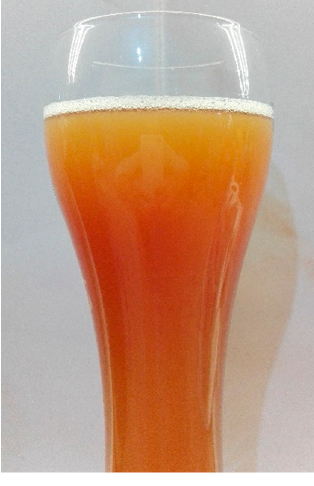
Figure 1. Haze in wheat beer.